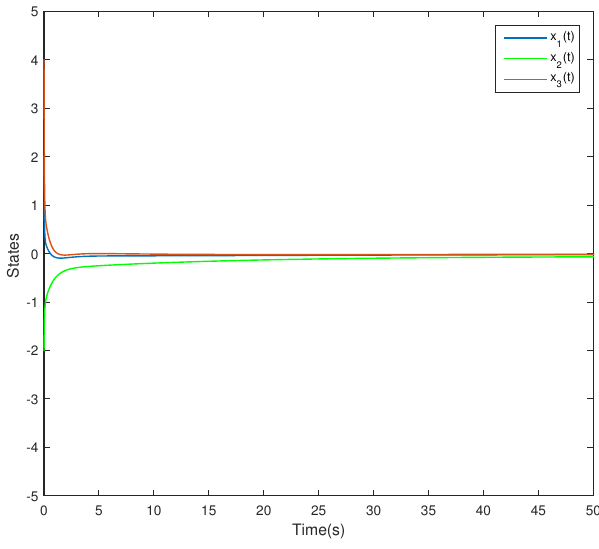
Figure 1. States responses of singular FOS in Example